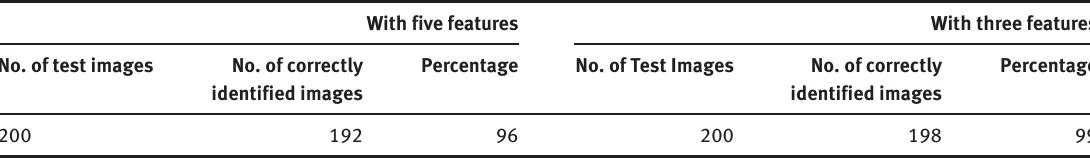
Table 5: Recognition Accuracy.